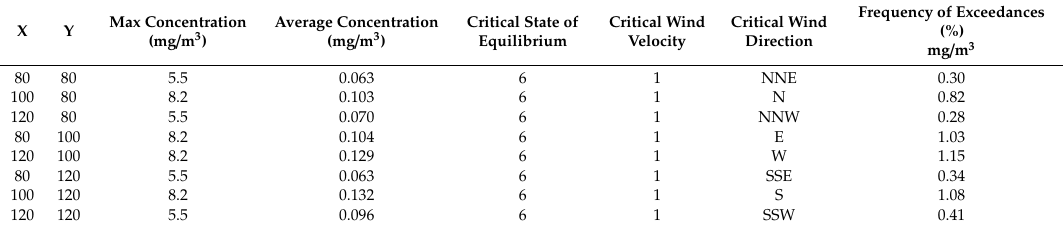
Table 4. Calculated concentrations of aliphatic hydrocarbons in the network of sensors at a height of 10